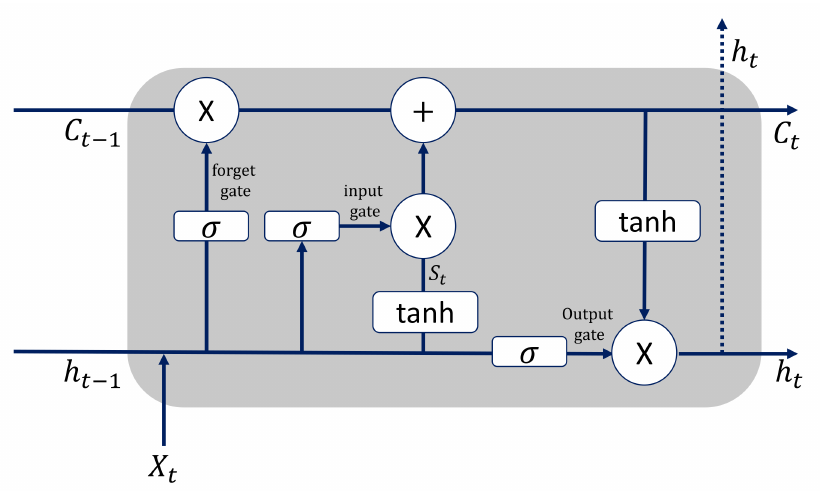
Figure 3. Architecture of the long short-term memory